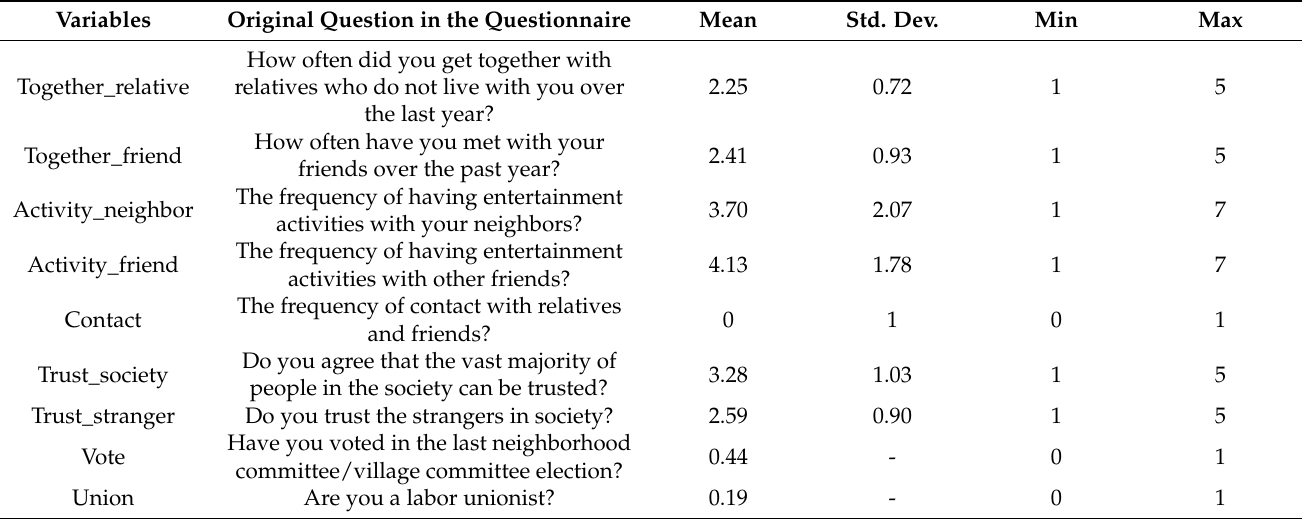
Table A1. Survey Questions about Social Capital.